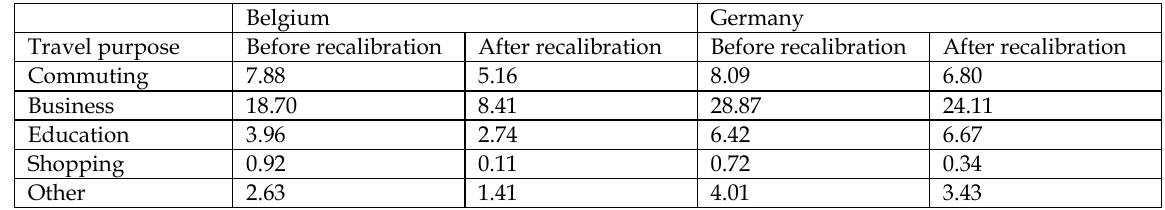
Table 7. Border resistance expressed in euros